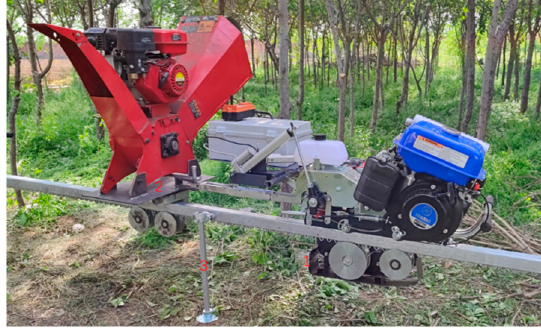
Figure 7. Schematic diagram of vibration test points.